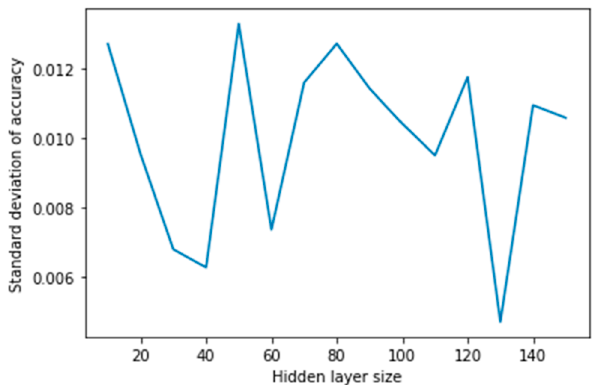
Figure 11. Standard deviation of accuracy depending on the number of neurons in the hidden layer for the respondent’s authenticity classifier.